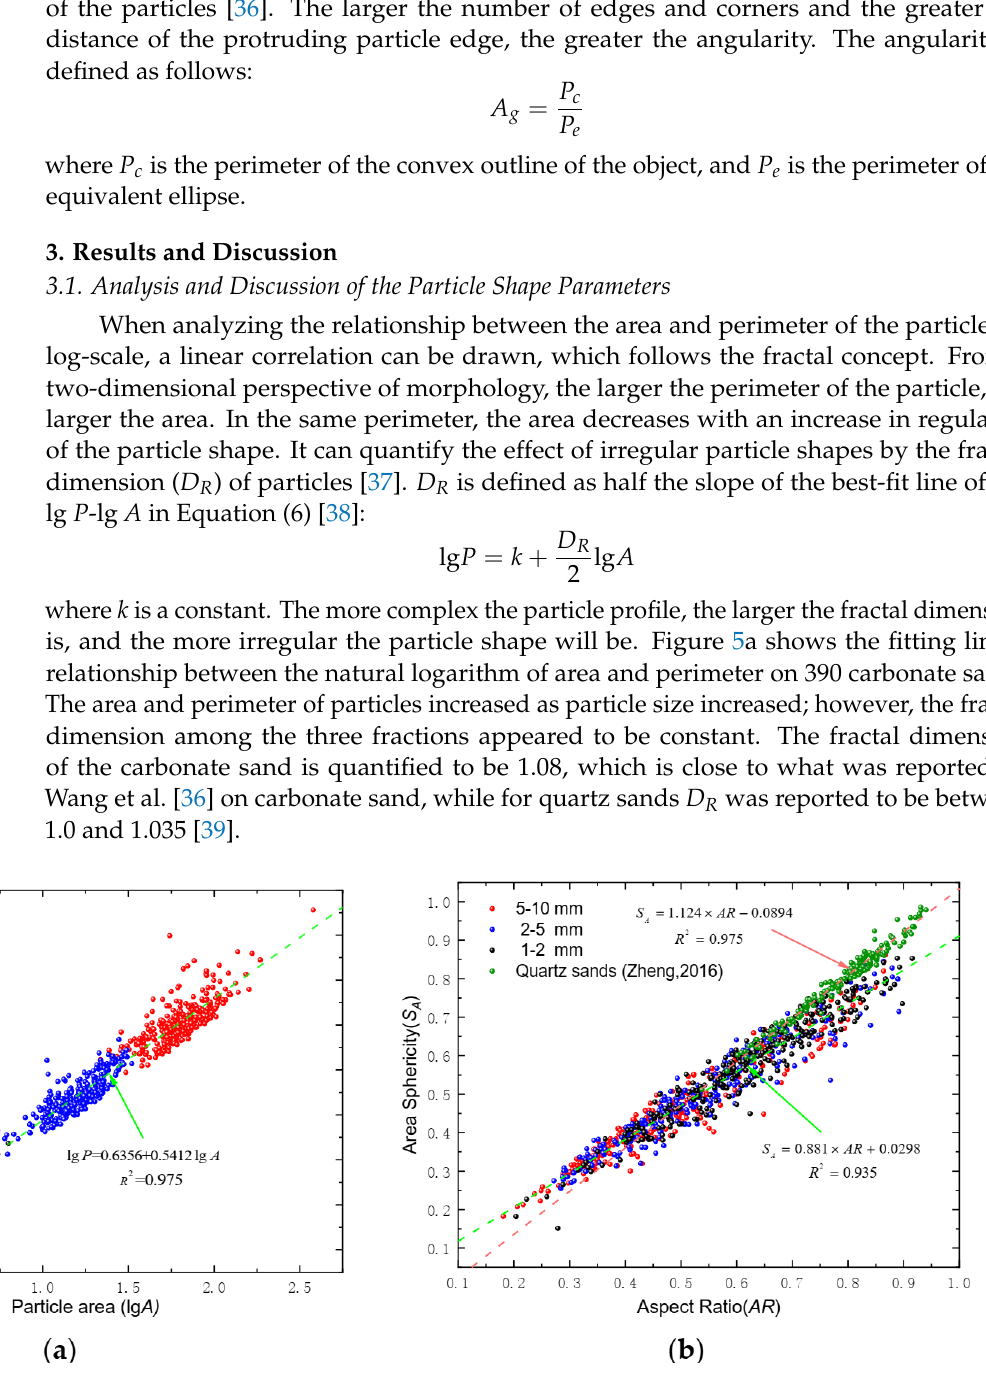
Figure 5. ( a ) lgP–lgA fitting curve of carbonate sand; ( b ) AR-SA fitting curve of carbonate